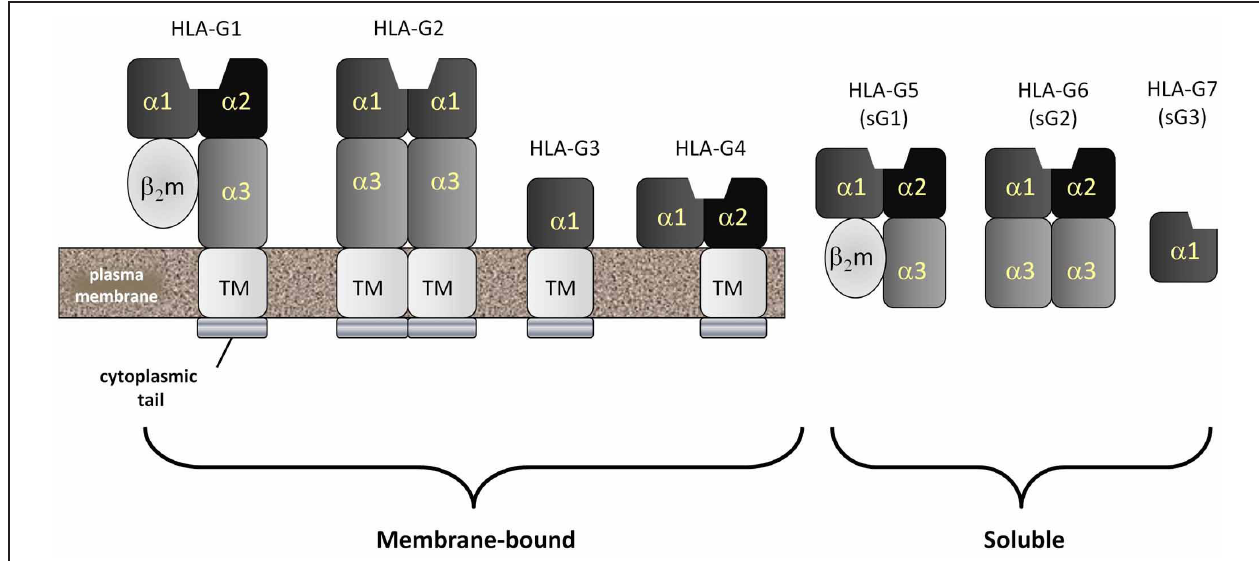
cytopalasmic tail. Unlike classical MHC class I molecules, the cytoplasmic tail of HLA-G is very short, containing only six amino acids. Also unlike classical MHC class Ia molecules, HLA-G can be detected as several spliced variants. The most common of these are the membrane-bound HLA-G1, -G2, -G3 and -G4 and the soluble HLA-G5, -G6 and -G7. Soluble forms have lost their transmembrane segments and cytoplasmic tails during